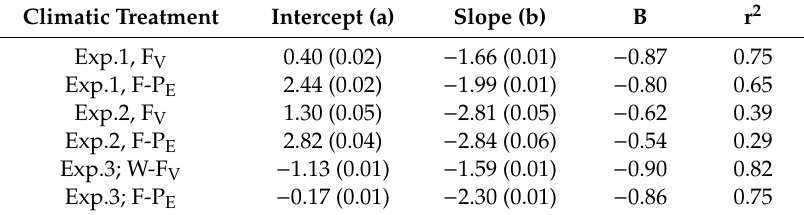
Table 2. Intercepts (a; ◦ C) and slopes (b; ◦ C kPa − 1 ) ( ± standard error) estimated based on a linear